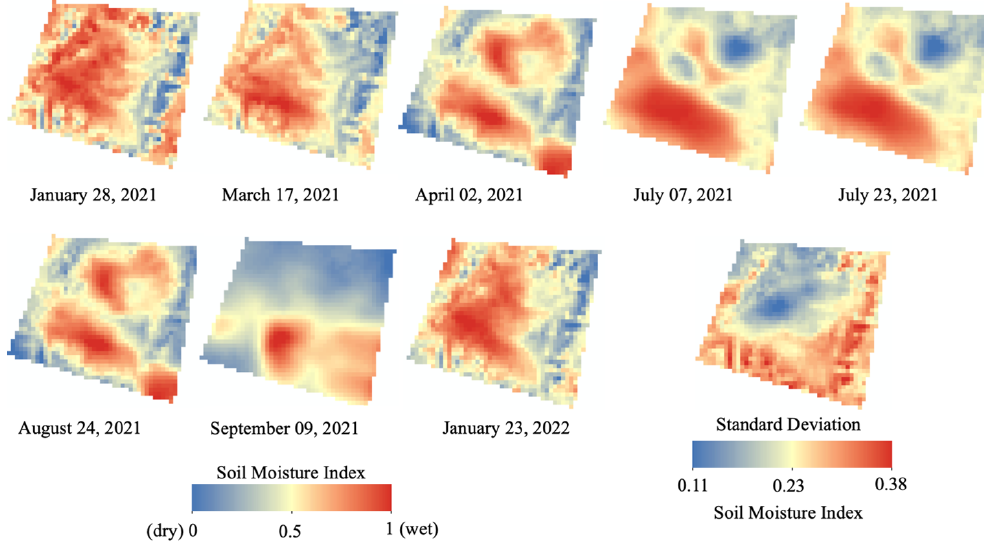
Figure 8. Soil moisture index from 28 January 2021 to 23 January 2022.